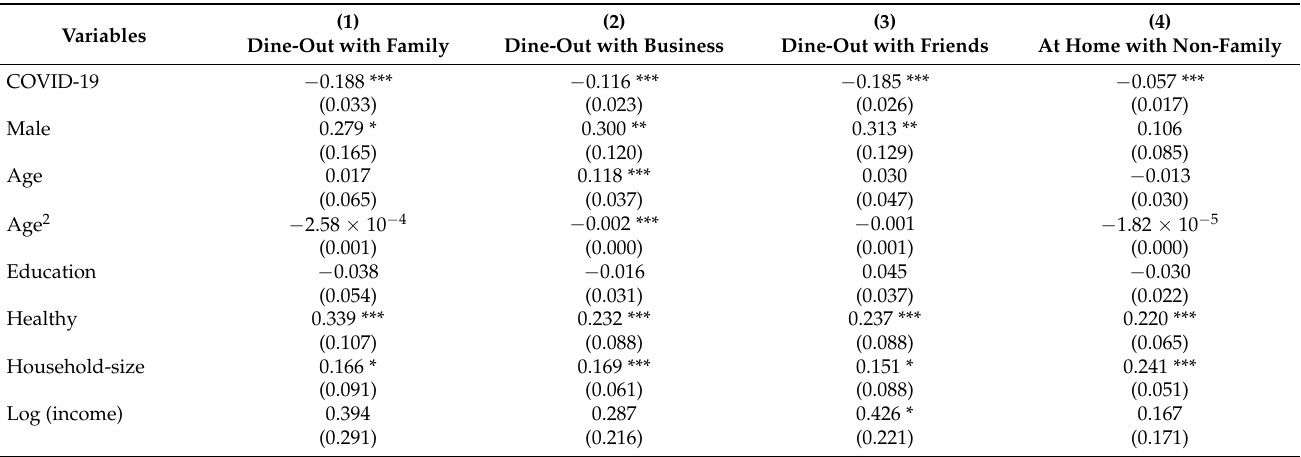
Table 5. The impact of the pandemic on the number of meal gatherings in June 2019 and June